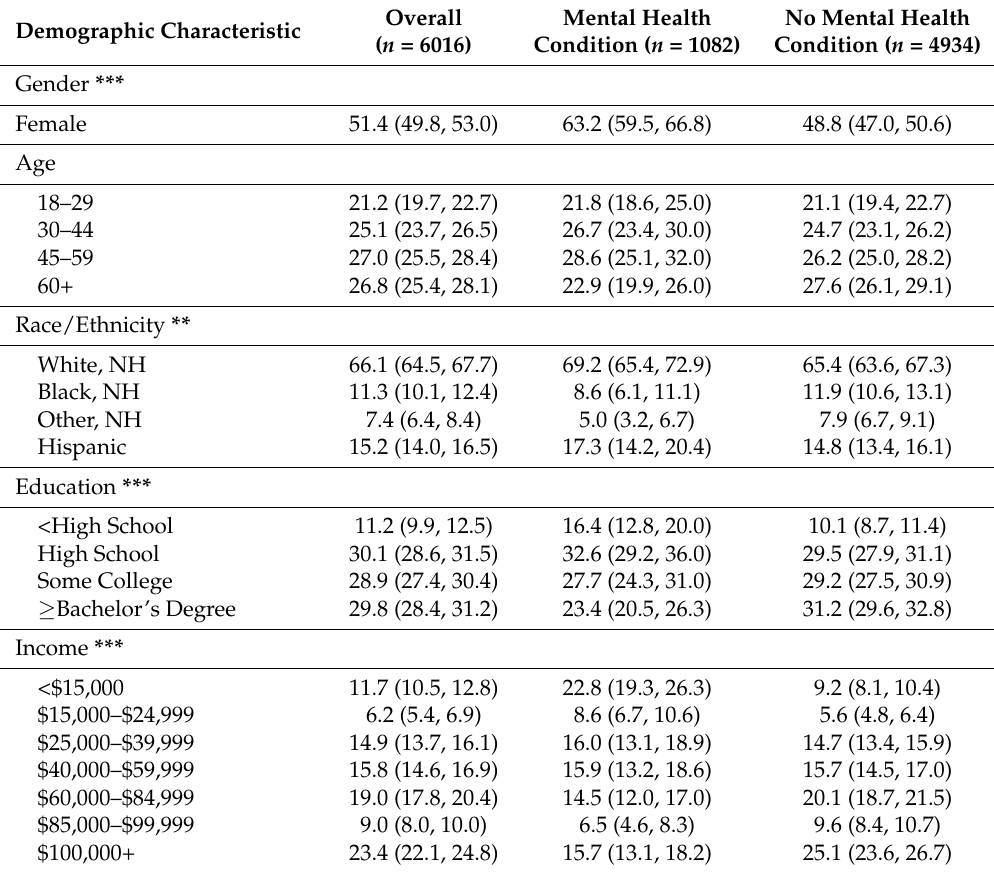
Table 1. Demographics characteristics (%) by lifetime mental health